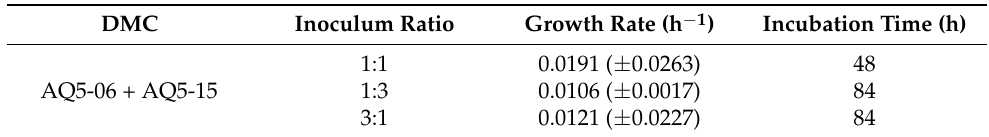
Table 2. Time taken for binary consortium with different inoculum ratios to completely degrade 0.5 g/L phenol at 10 ◦